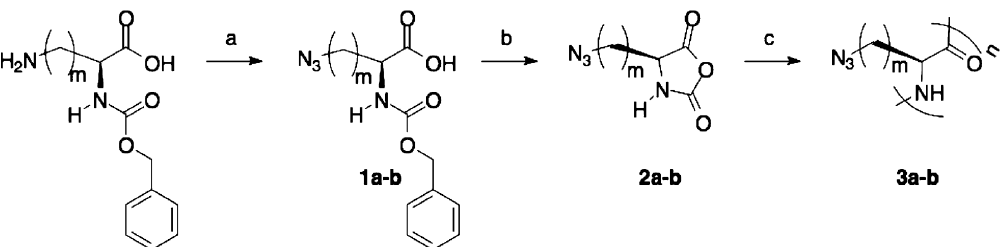
Figure 5. Synthesis of azide-containing NCAs. (a) Imidazole-1-sulfonyl-azide·HCl, CuSO 4 ·5H 2 O,